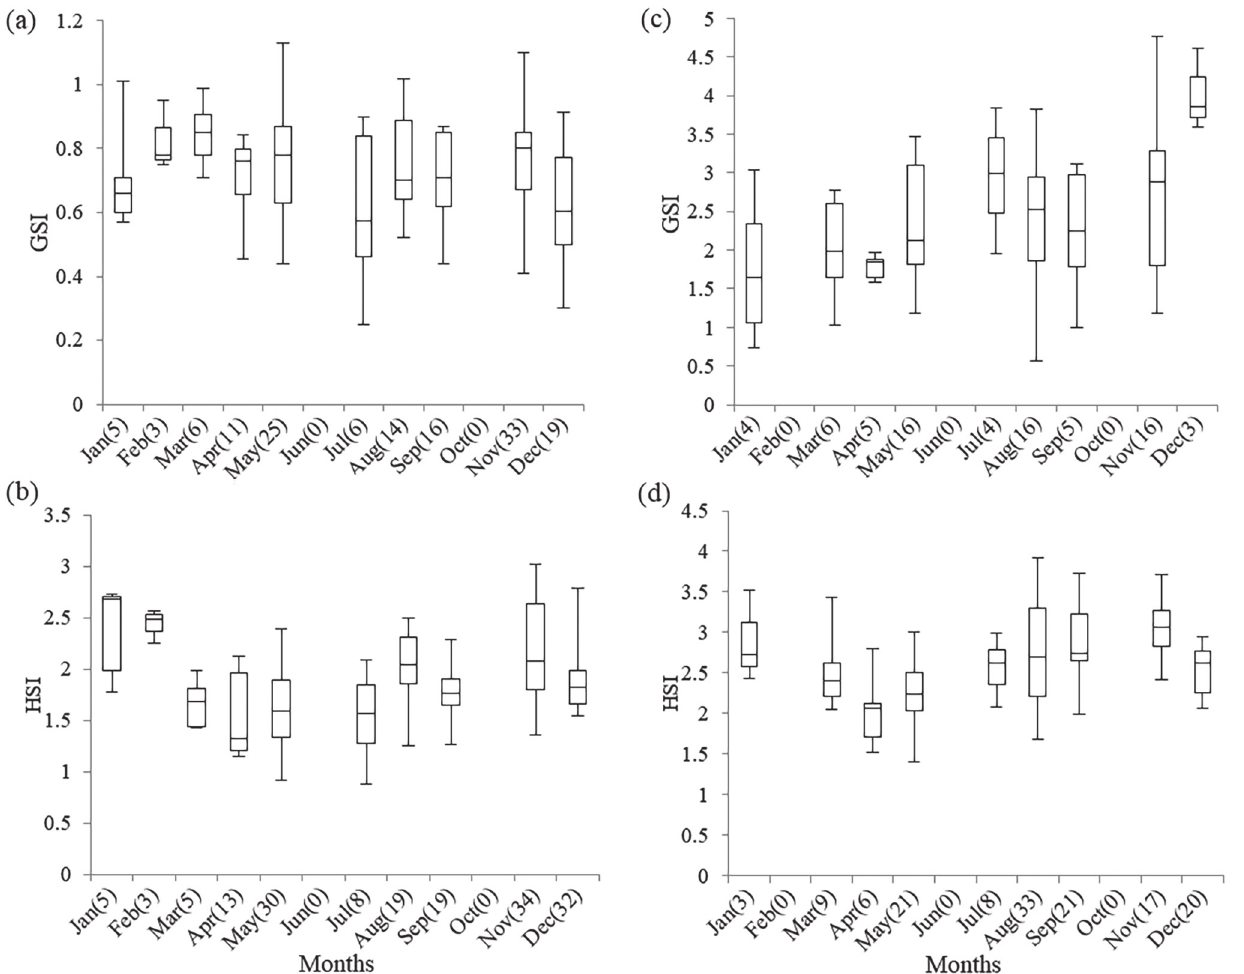
Fig. 6 . Seasonal variation in gonadosomatic (GSI) and hepatosomatic (HSI) indexes for a.-b. males and c.-d. females of Atlantoraja cyclophora. The number of samples analyzed is between parentheses. The boxes represent the interquartile range between Q1 and Q3 with the 50% of data, the central line represents the median value and whiskers extend to the maximum and minimum